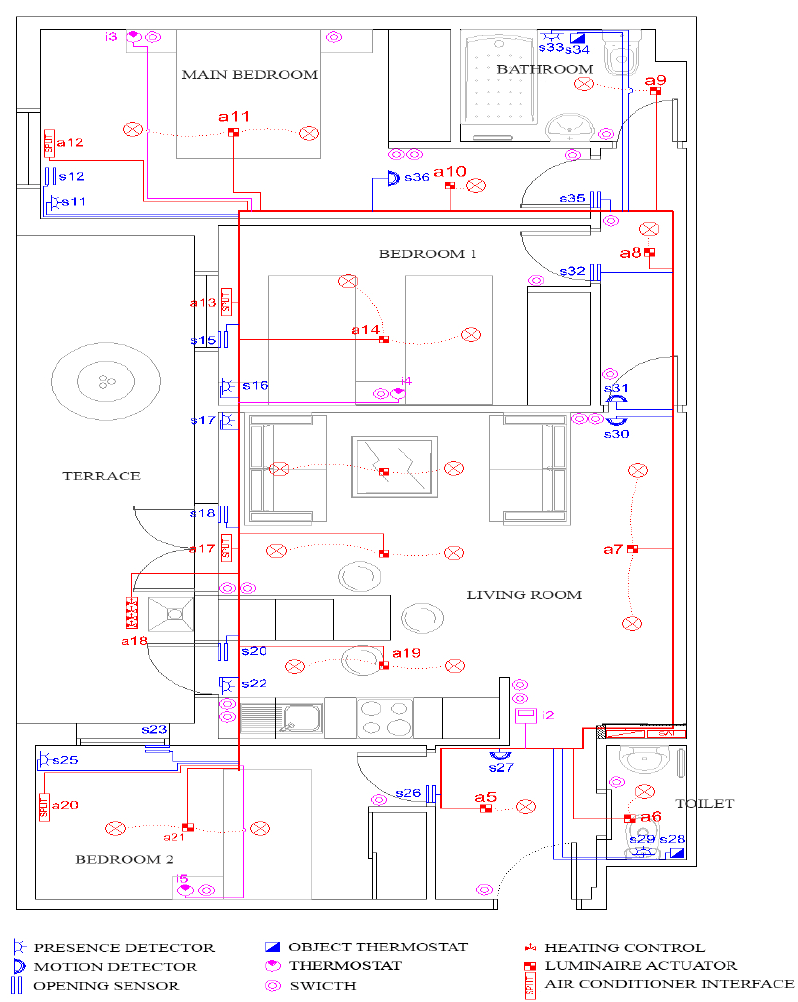
Figure 3. Components distribution for basic home automation system.